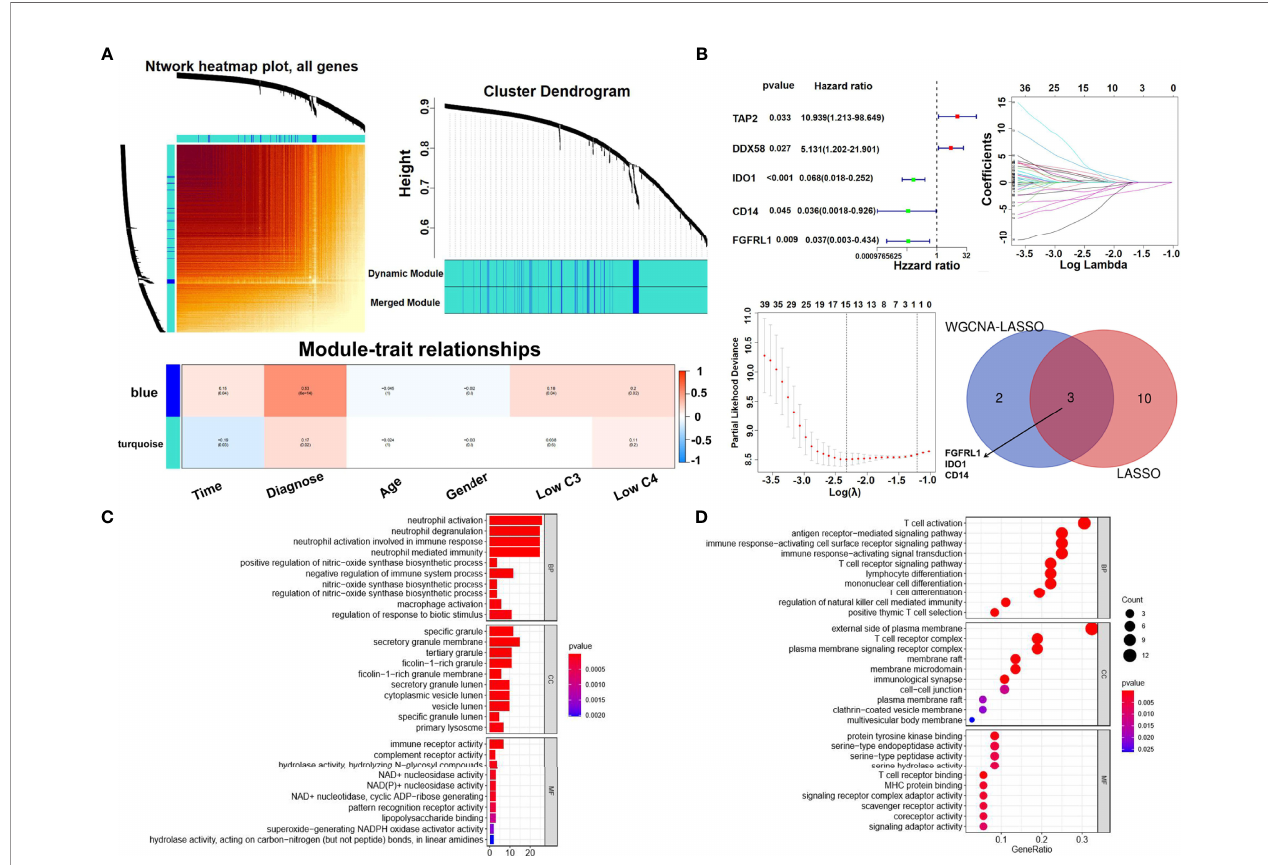
FIGURE 9 | Gene modules, univariate Cox regression, and functional analysis of immune genes. (A) Gene modules identi fi ed by WGCNA. Correlation between gene modules and clinical features. Strongly correlated modules (|Cor> 0.5, p < 0.05) are marked with red frames. (B) Univariate Cox regression analysis of immune genes in the GSE49454 dataset. Partial likelihood deviance of different numbers of variables and LASSO coef fi cient pro fi les of immune genes in the GSE49454 dataset are shown. Venn diagram to identify key immune genes between WGCNA-LASSO and LASSO analysis. (C) Bar plot graph of GO enrichment based on the immune genes in the GSE49454 cohort (a longer bar means the more genes enriched, and an increasing depth of red means the differences were more obvious). (D) Bubble graph for KEGG pathway enrichment based on the immune genes in the GSE49454 cohort. (a larger bubble means that more genes were enriched, and an increasing depth of red means that the differences were more